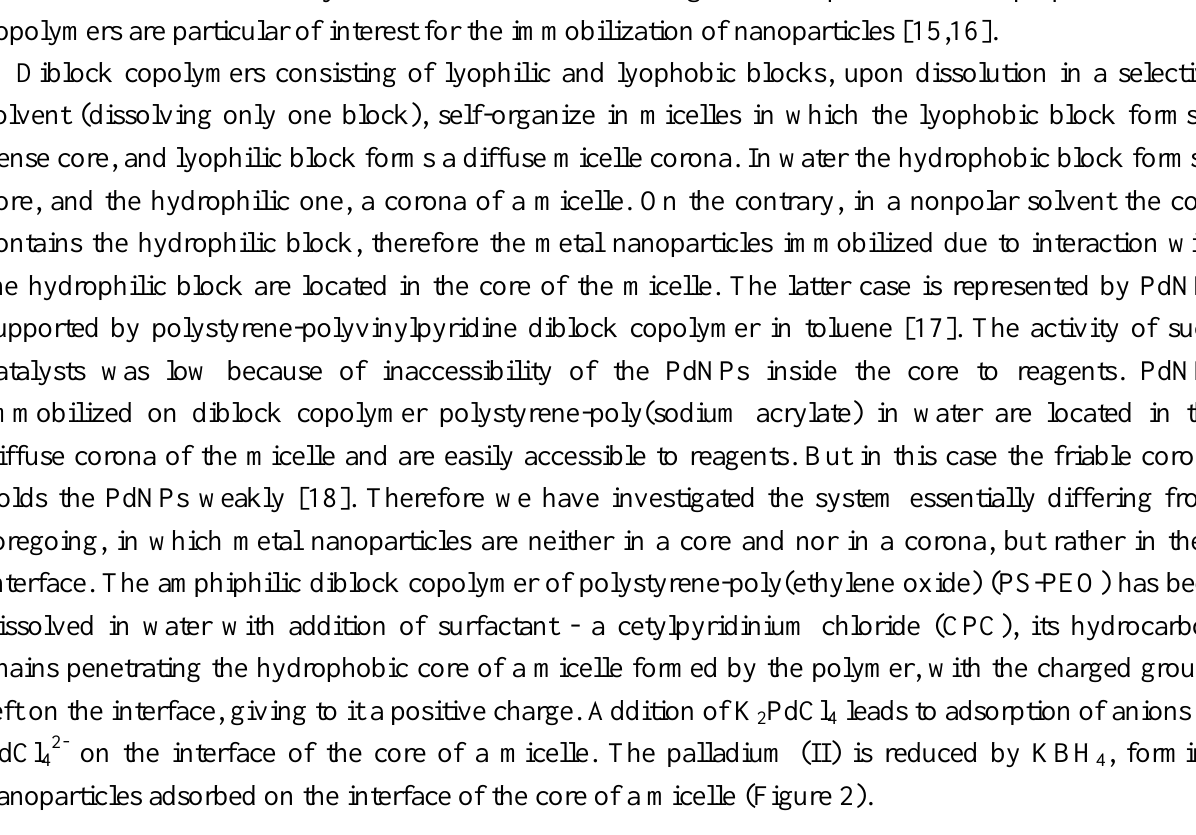
Figure 2. The scheme of formation of micellar